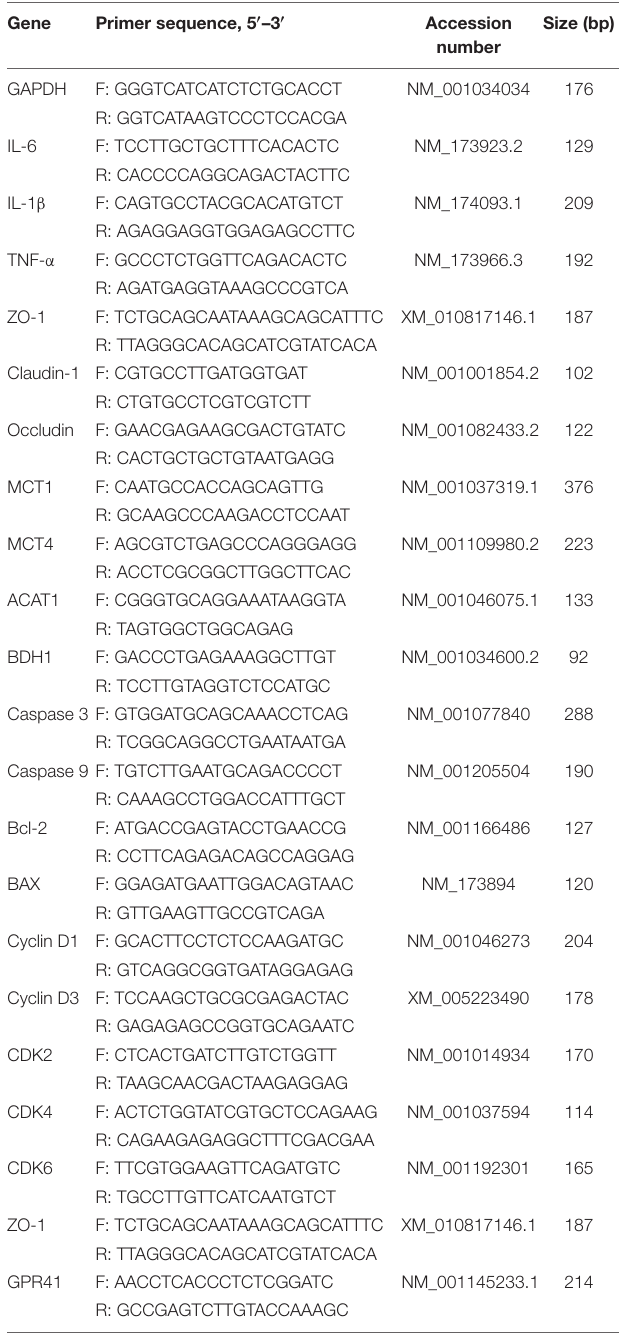
TABLE 1 | Primers for real-time PCR